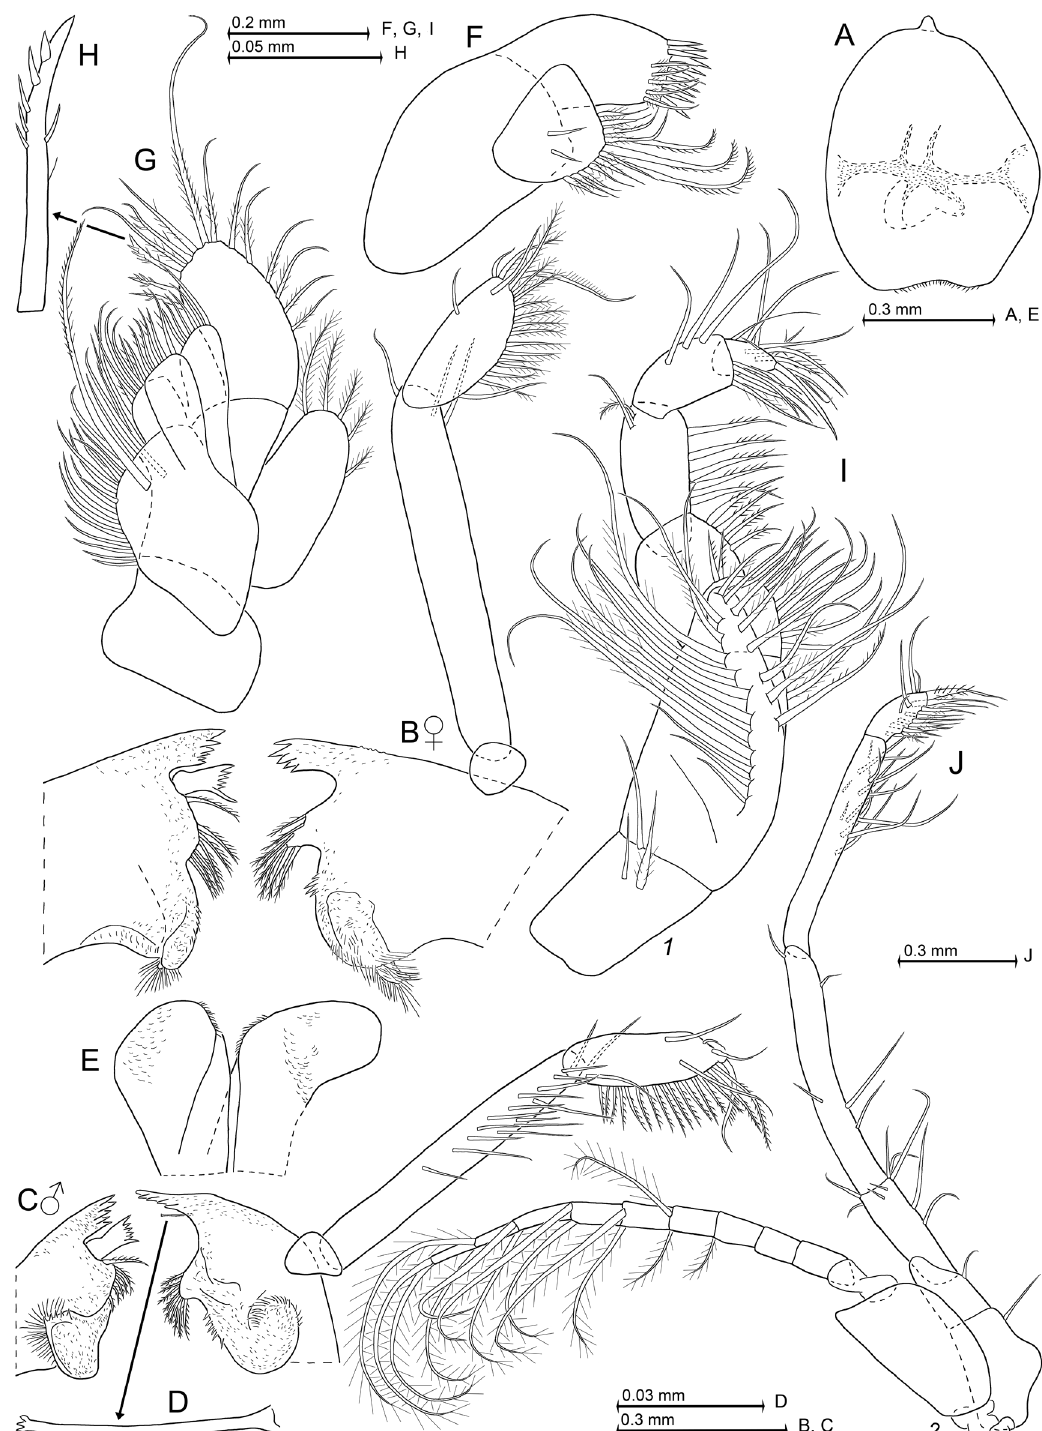
Fig. 6. Abyssomysis cornuta gen. et sp. nov., paratypes female with body length 7.9 mm (A–B, E–F, I: ZMH 58256) and males 6.7 mm (C–D, G–H: ZMH 58254), 6.8 mm (J: SMF 55190). A . Labrum. B–C . Mandibles with right palpus in female (B) and male (C), rostral. D . Detail of panel (C) showing reduced lacinia mobilis in right mandible of male. E . Labium. F . Maxillula. G . Maxilla. H . Detail of G showing modified spine-seta. I . First thoracic endopod. J . Second